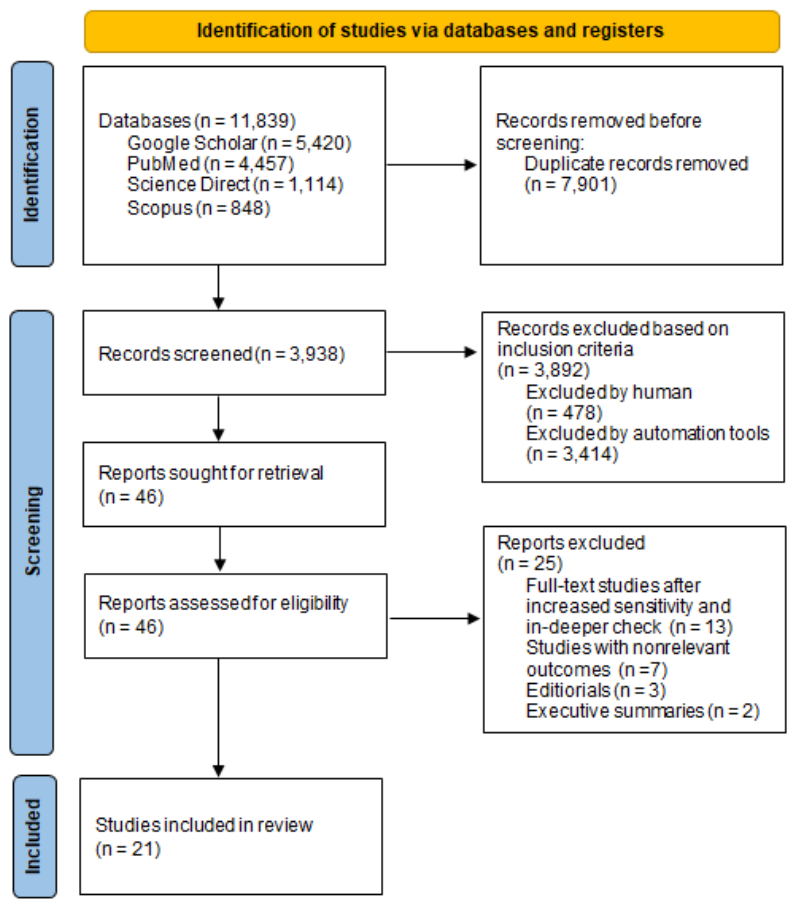
Figure 1. Collecting adequate studies on the basis of pre-defined criteria (PRISMA flow chart).